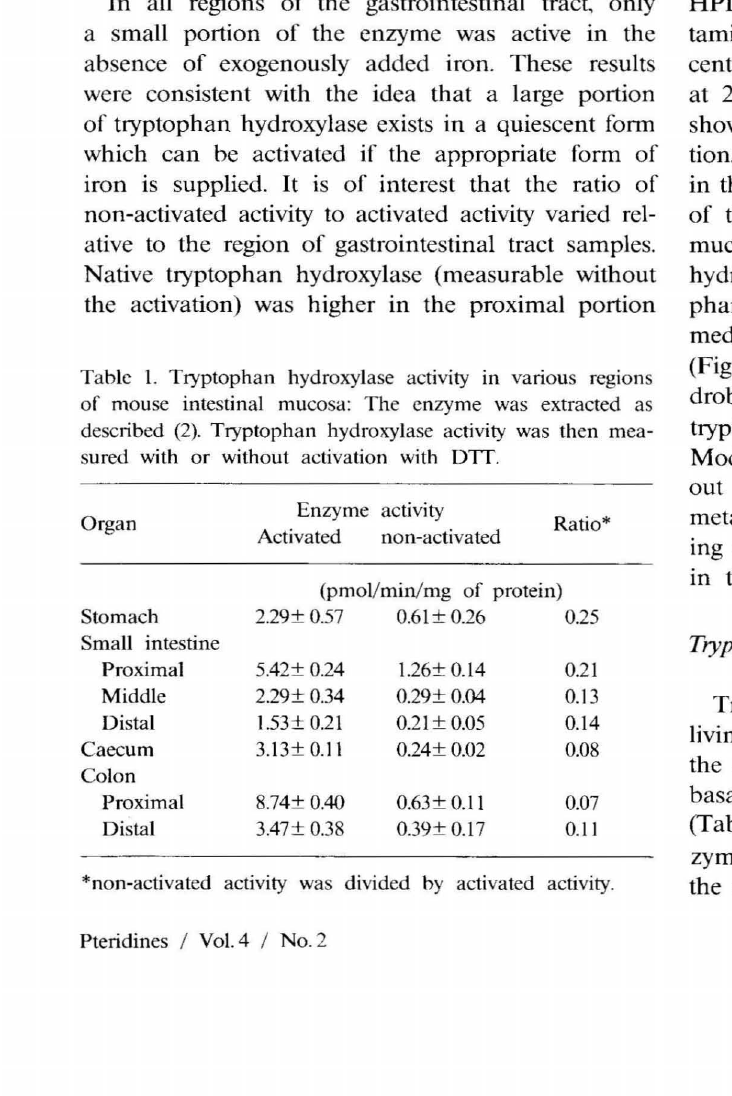
Table 1. Tryptophan hydroxylase activity in various regions of mouse intestinal mucosa: The enzyme was extracted as described (2). Tryptophan hydroxylase activity was then mea sured with or without activation with DTT.